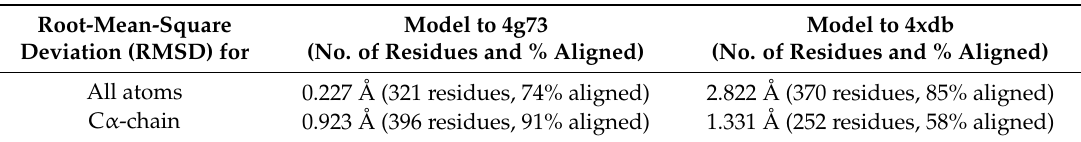
Table 1. Results of the 3D structural alignment between the Li NDH2 homology model and the